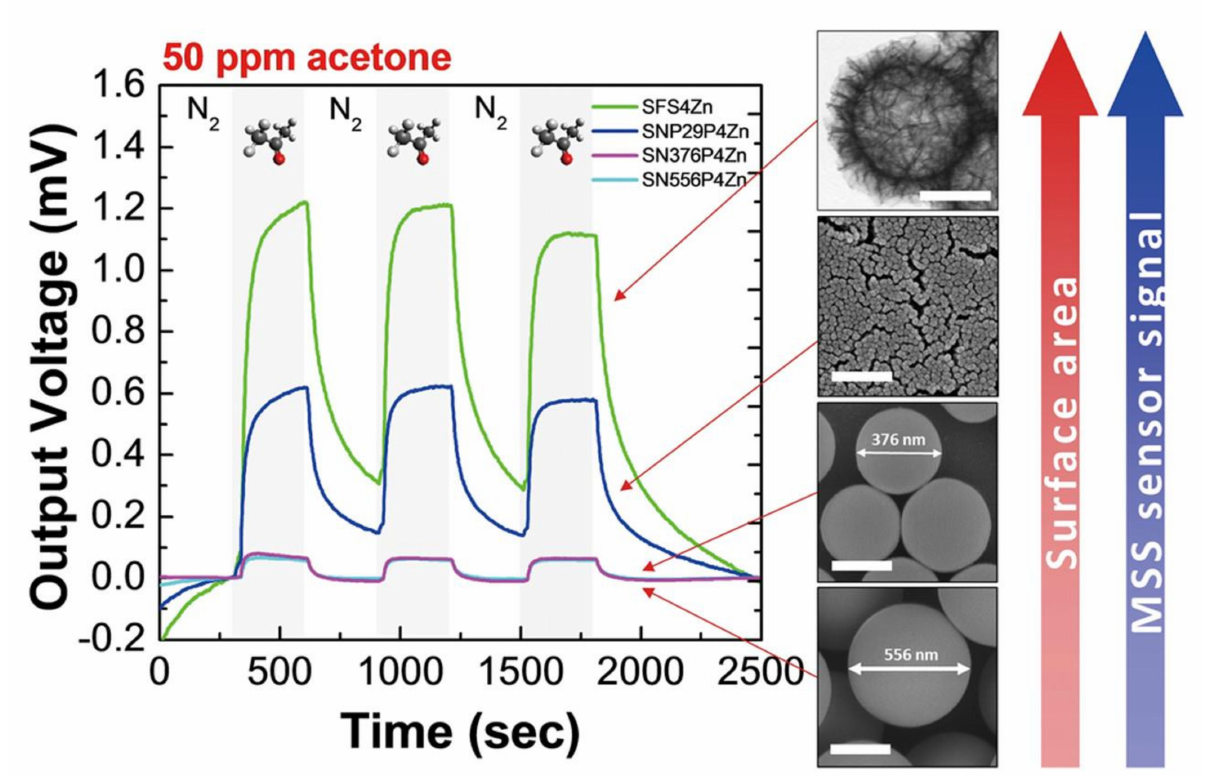
Figure 11. Signal response of MSS coated with Zn porphyrin-functionalized solid silica particles with diameters of 29 nm (SNP29P4Zn; blue line), 376 nm (SNP376P4Zn; light blue), and 556 nm (SNP556P4Zn; pink), or with Silica Flake–Shell bearing Zn porphyrin (SFS4Zn; green line) to 50 ppm acetone in nitrogen. Corresponding SEM micrographs are shown; the white scale bars are 250 nm. Reprinted with permission from Ref. [139]. Copyright 2017, American Chemical